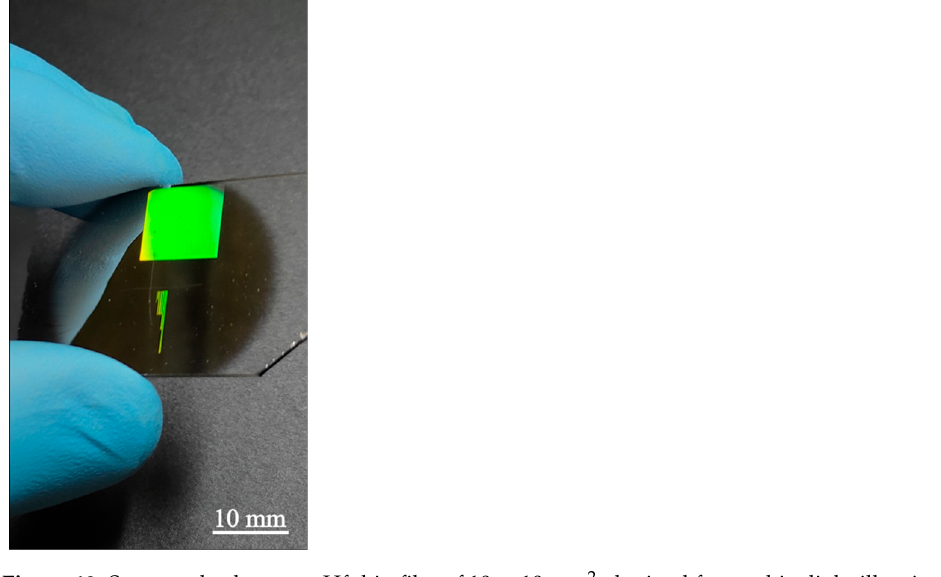
Figure 10. Structural colors on a Hf thin film of 10 × 10 mm 2 obtained from white light illumination. The corresponding LIPSS pattern was obtained in air at 2000 um/s and 250 mW.